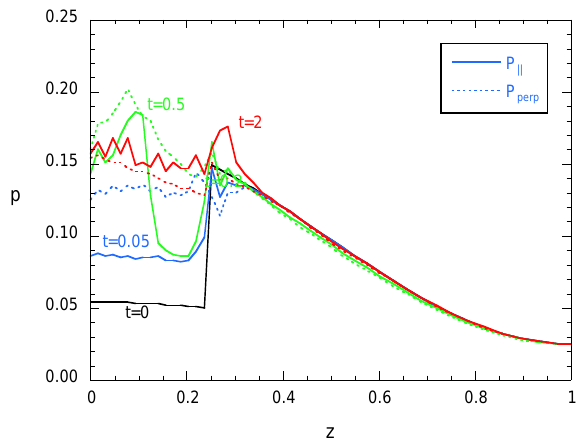
Fig. 15. Plasma pressure components for a narrow flux tube with y m = 0 . 02 in a double-adiabatic model, at x =− 7 . 4 ,y = 0 as a func- tion of z at different times, as indicated.